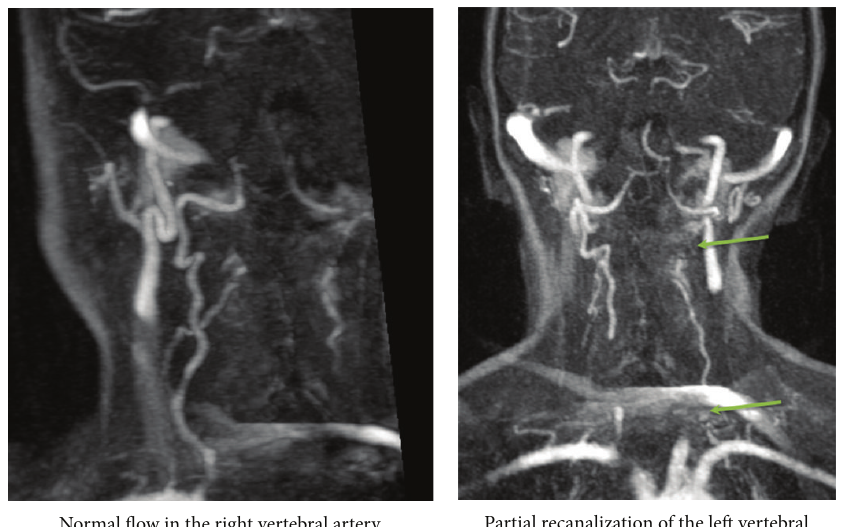
Figure 3: MRI angioscan (FLASH 3D coronal images after Gd-chelate